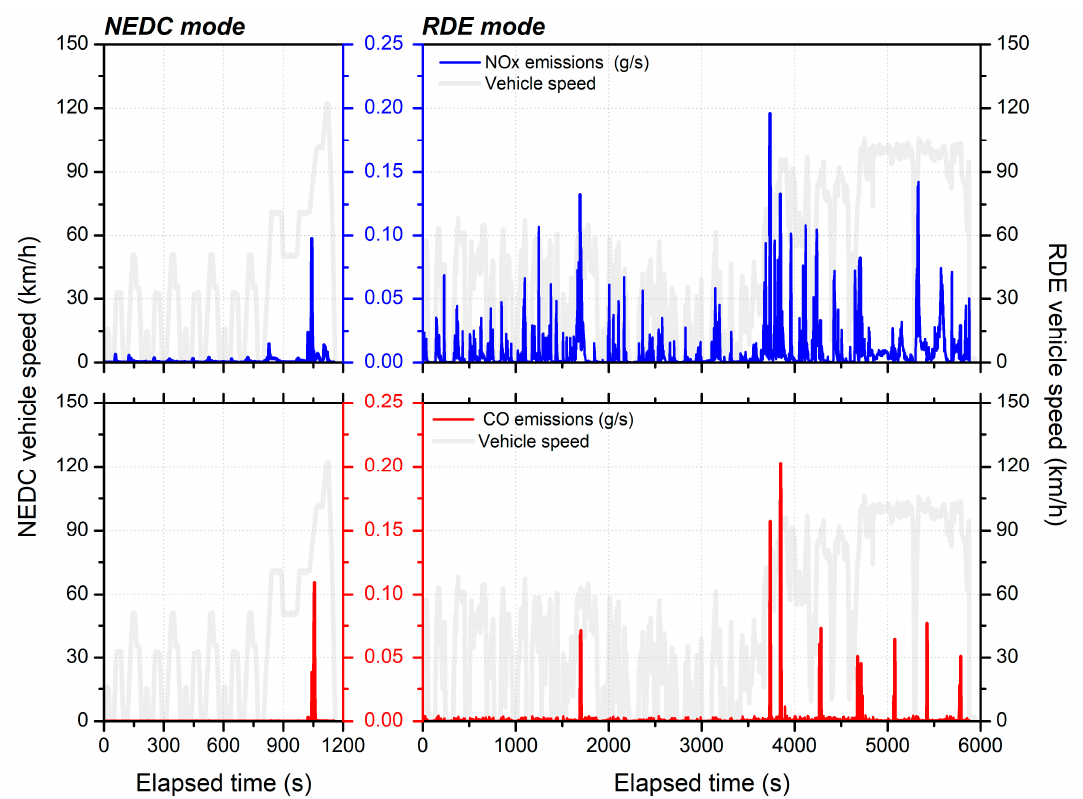
Figure 9. Operational characteristics of the lean-NOx trap (LNT) in Real Driving Emissions (RDE) and New European Driving Cycle (NEDC) test conditions.